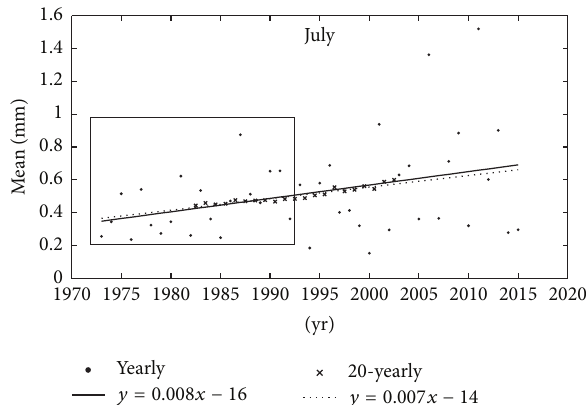
Figure 2: Time series of the 1-hour mean precipitation observed in July at Seoul observation station. Dots are the yearly mean values, and crosses are the 20-yearly mean values. Solid and dotted lines are the least square fit linear regression line of the yearly and 20-yearly mean values,